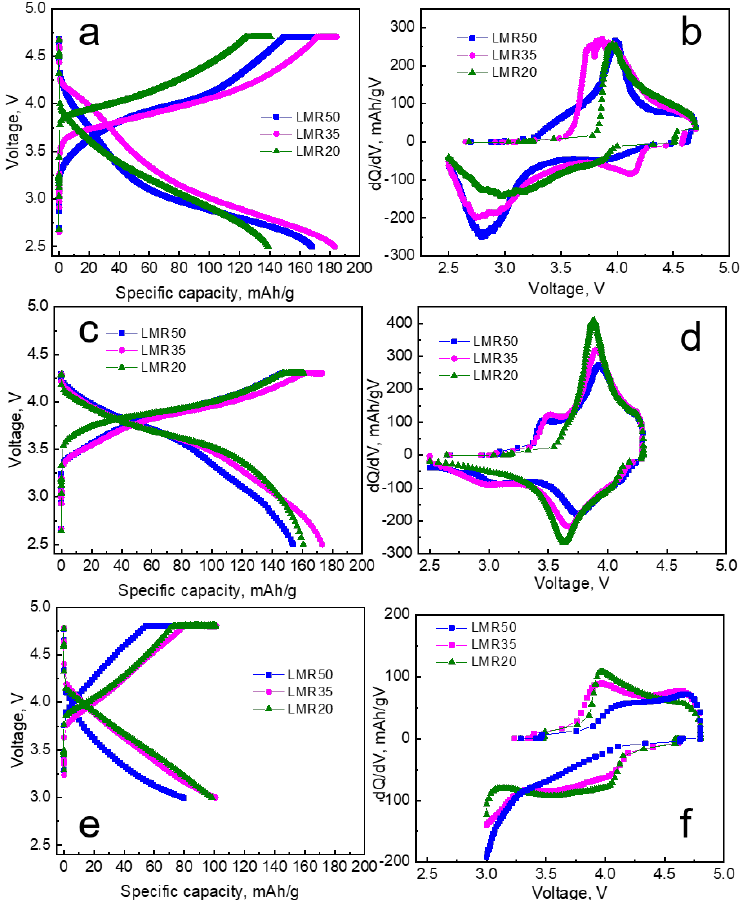
Figure 9. ( a , c , e ) Charge—discharge profiles and ( b , d , e ) dQ/dV curves in the 100th cycle for the different compositions in the voltage ranges of 2.5–4.7, 2.5–4.3, and 3.0–4.8 V, respectively; the current density is equal to 80 mA/g.